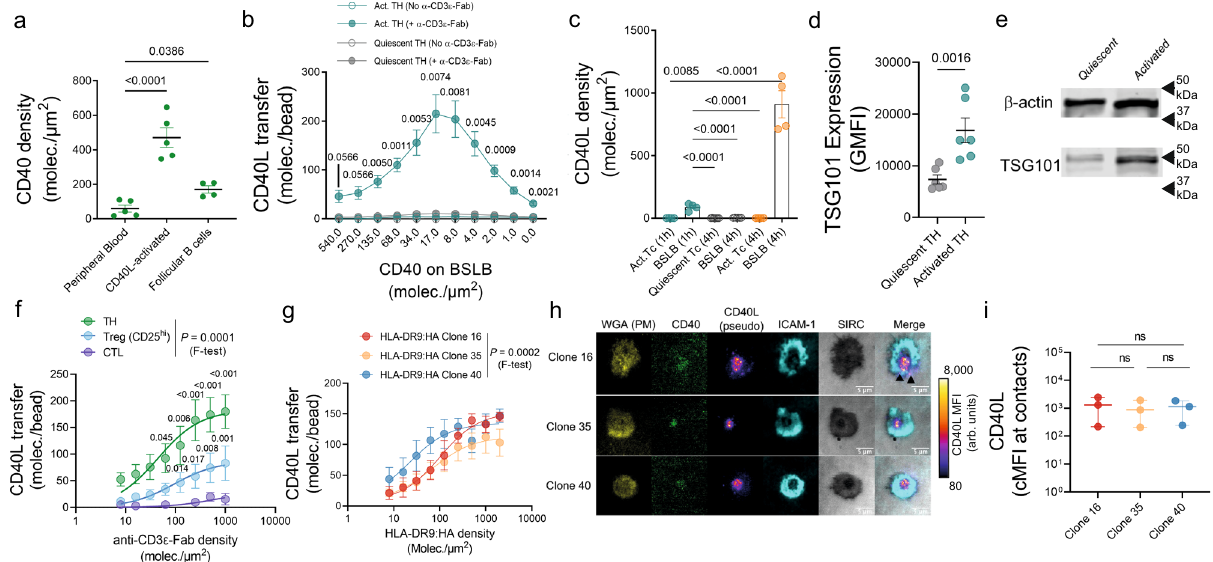
Fig. 3 BSLBs unravel the dynamics in fl uencing the biogenesis of CD40L + tSV. a CD40 densities on the surface of human B cells isolated from either peripheral blood (CD19 hi HLA-DR + and CD40 + ) or palatine tonsils (also CXCR5 hi ). b Transfer of CD40L + tSV to BSLBs reconstituted with physiological densities of CD40 (as de fi ned in a ) and either no or 1000 molec./ µ m 2 of α -CD3 ε Fab. Quiescent and α -CD3/CD28-activated and expanded TH are compared. c Density of CD40L molecules transferred to BSLB at different times by quiescent and activated cells. CD40L density was estimated using a previously de fi ned 5 patch area of 0.82 µ m 2 . d TSG101 expression in quiescent and activated TH as measured by fl ow cytometry. e Immunoblots showing TSG101 expression in quiescent and activated TH. f Absolute CD40L transferred to BSLBs from TH, Treg, and CTL. g Absolute CD40L transferred to BSLBs from T-cell clones expressing TCRs with different potencies for the antigenic HLA-DRB1*09:01:HA 338 – 355 complex. h TIRFM imaging of CD40L clustering within synapses of T-cell clones stimulated on SLB containing 30 molec./ µ m 2 of antigen, 200 molec./ µ m 2 of ICAM1, and 20 molec./ µ m 2 of CD40. Scale bar = 5 µ m. MFI = mean fl uorescence intensity, arb. units = arbitrary fl uorescence units. SIRC = surface interference re fl ection contrast; Plasma